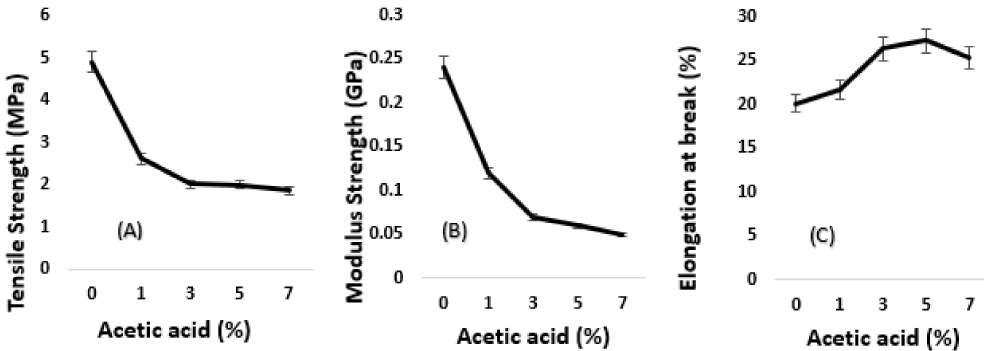
Figure 1. Effect of acetic acid on ( A ) tensile strength; ( B ) modulus strength; and ( C ) elongation at break of algae-based